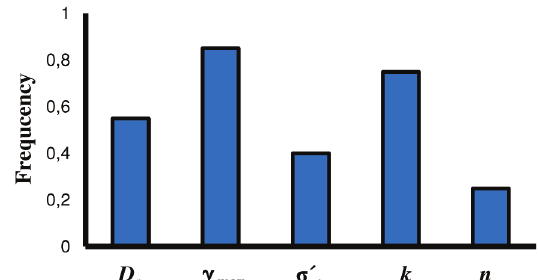
Fig. 7. Contributions of the predictor variables in the LGP Table 7. Overall performance of the proposed formulation of strain–stress relationship Model